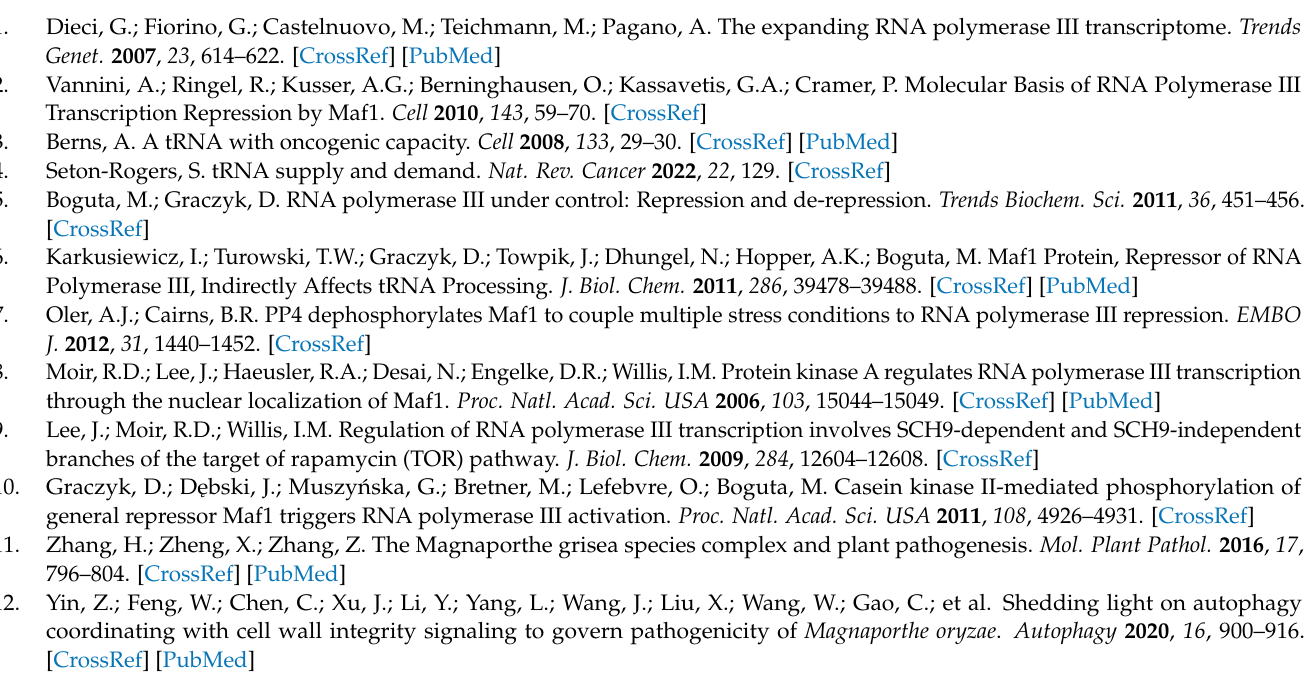
Figure S3. Statistical analysis of the appressorium formation rate. Figure S4. MoMaf1 is involved in appressorium turgor generation. Figure S5. MoMaf1 is involved in cell wall stress response. Table S1. Primers used in this